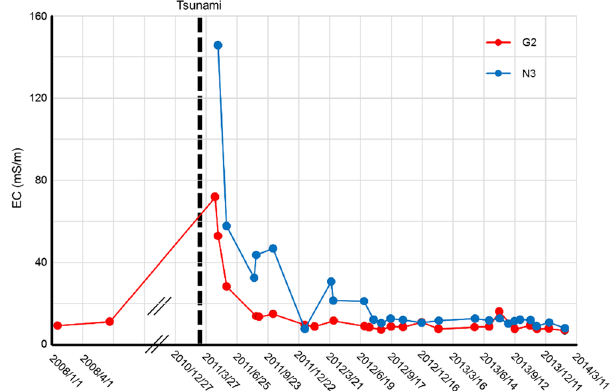
Figure 2. Changes in the electrical conductivity (mS/m) of the Gensui and Namaisawa Rivers. The broken line indicates the timing of the 2011 off-Pacific coast Tohoku Earthquake (March 11,